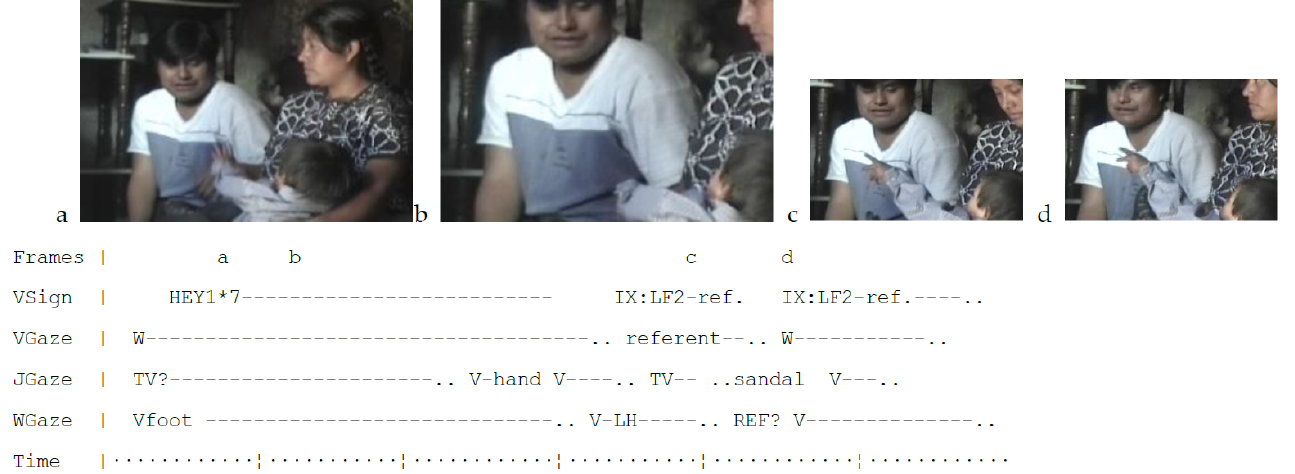
Figure 21. As Will played with his foot, Vic, at 25 mos., tried for 4 s to get his attention. ( a ) Vic began to make the HEY1 sign at Will repeatedly. It took four full seconds for Will to respond to his nephew’s request for attention, during which time Vic continued to wave his hand making the HEY1 sign. It is hard to discern from the video stills, but during his delayed response, Will was pointedly gazing at Vic’s feet and playing with his sandals, doggedly avoiding a response to Vic’s HEY. Jane, in turn, appeared to be watching the TV screen in front of her. She first glanced down at Vic’s signing hand just before Will also appeared to see it. Once his gaze moved to Vic’s HEY1 sign, close attention to the dance of Will’s eyes shows that ( b ) he attended first to Vic’s waving hand and ( c ) then looked at Vic’s face, realizing that the child wanted his attention. It was only at that point that ( d ) Vic began to form a pointing hand in the direction of the door—what he had apparently wanted to point out from the start. Vic’s reference to the door in turn prompted both Will and Jane to glance in that direction.